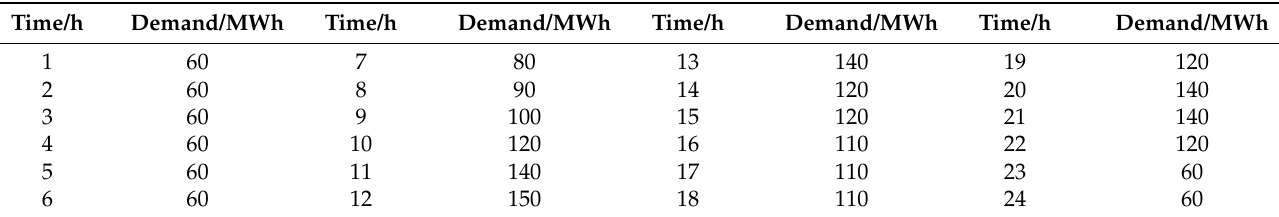
Table 4. Twenty-four-hour electricity demand.